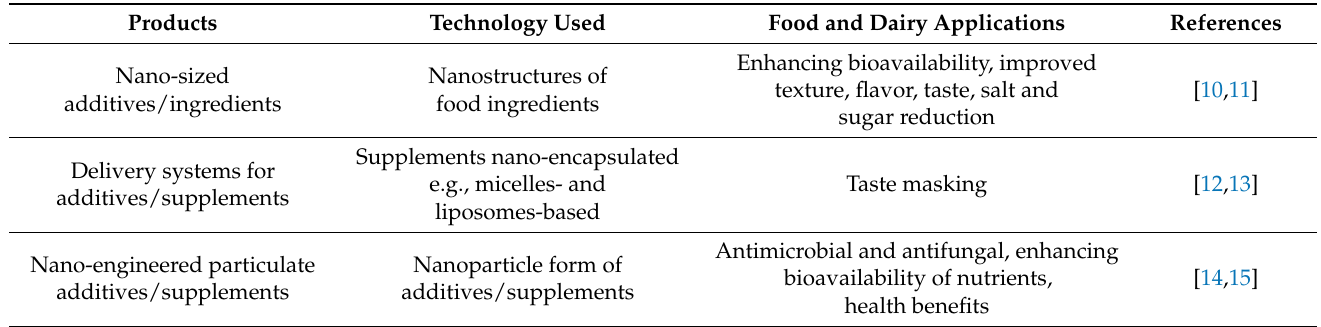
Table 1. Different nanotechnology applications for food and dairy industries and its